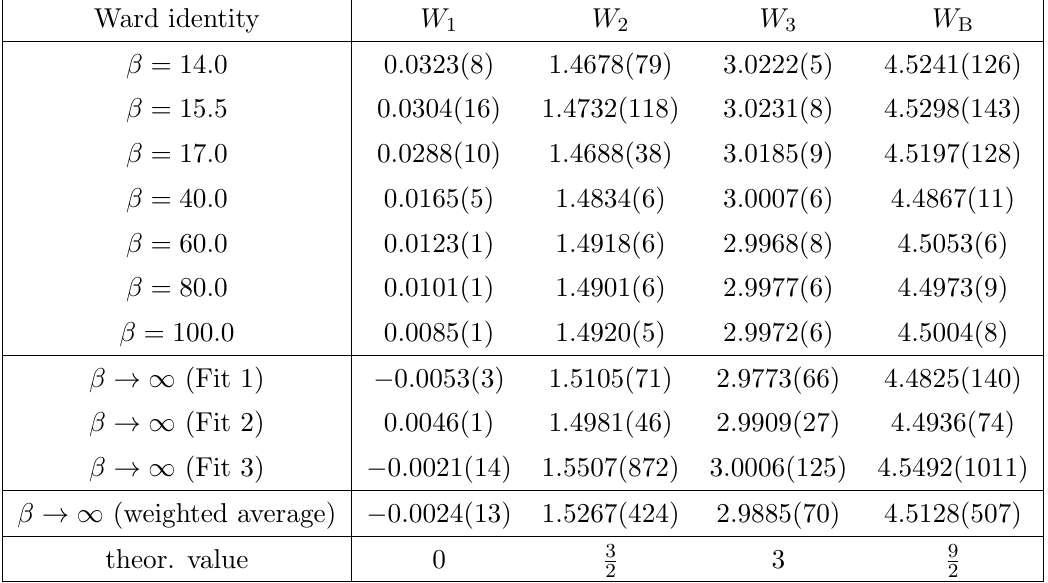
Table 7. Values of Ward identities for di(cid:11)erent values of (cid:12) on a 32 (cid:2) 16 lattice. The last (cid:12)ve rows contain the continuum extrapolations with three di(cid:11)erent (cid:12)t functions and a weighted average as well as the theoretical value for unbroken susy.